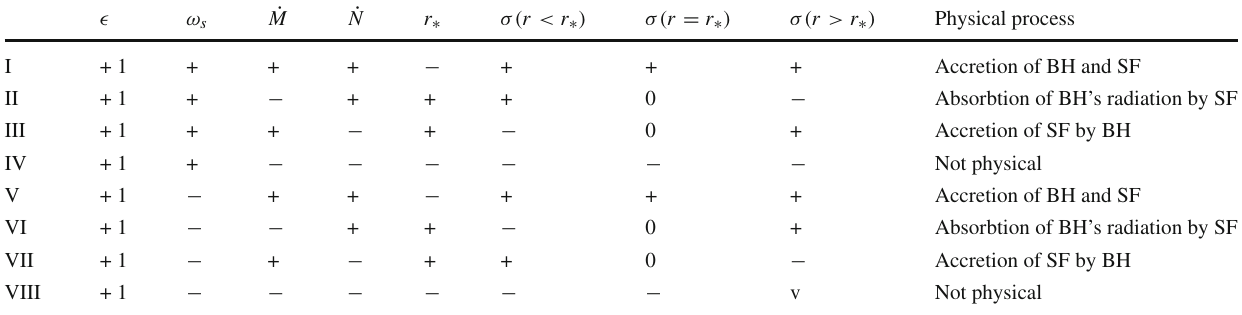
Table 2 General BH and SF parameters for (cid:5) = +